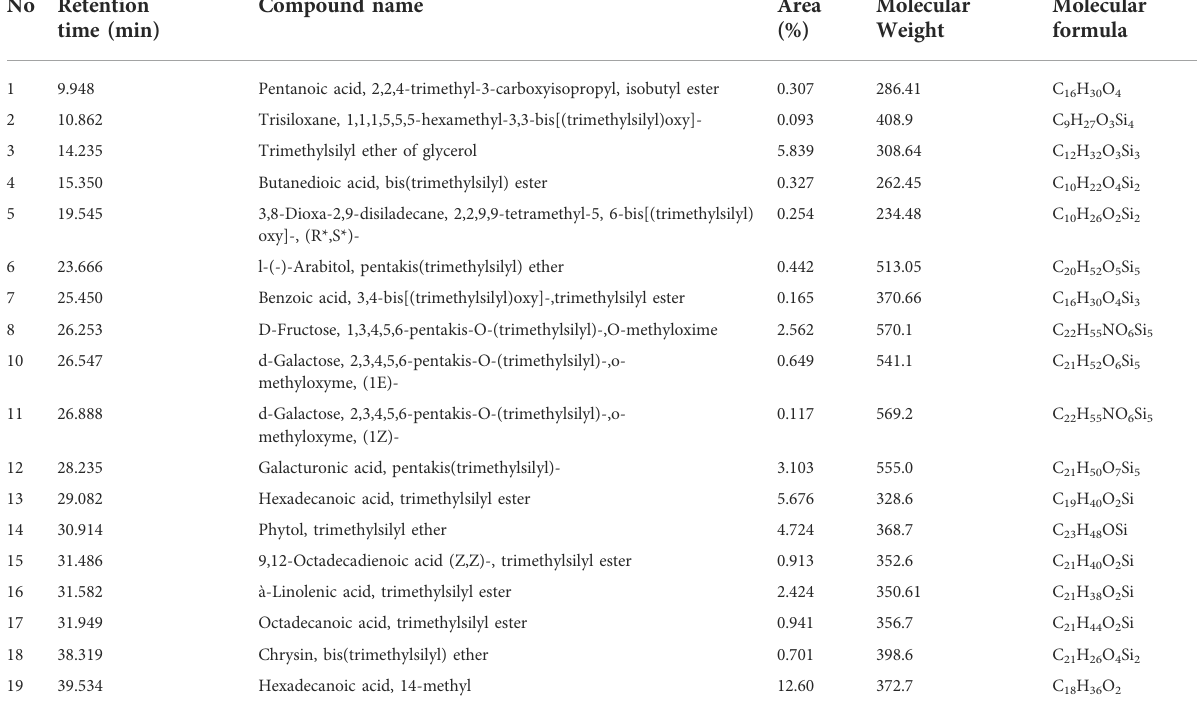
TABLE 1 GC-MS analysis revealed the presence of phytochemical components in ethanol leaf extract of Oroxylum indicum .